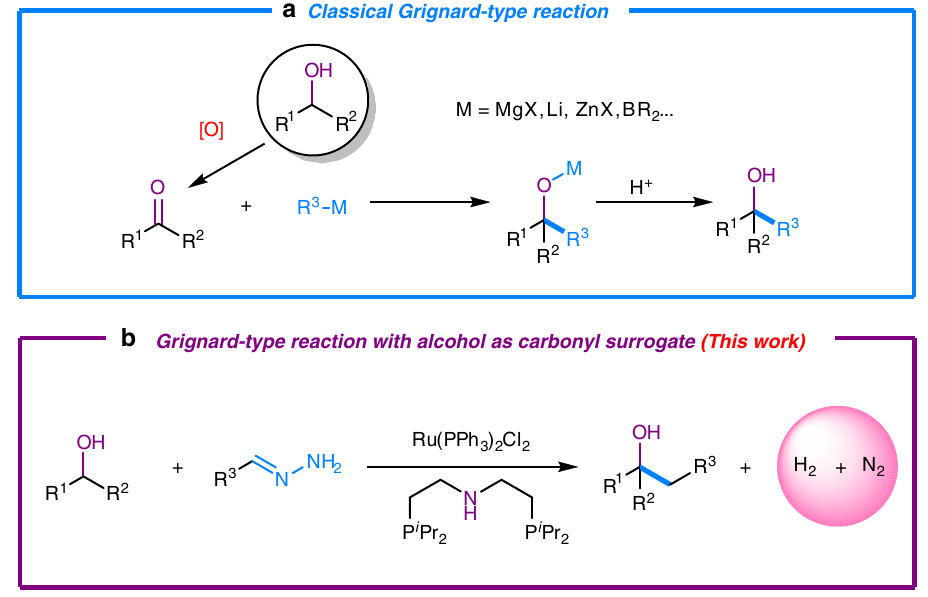
Fig. 2 Grignard-type reaction with alcohol as carbonyl surrogate. a Classical Grignard-type reaction uses carbonyls as starting materials which come from the oxidation of alcohols. Organometallic reagents, in this case, serve as carbanion equivalent. b Alcohol-surrogated Grignard-type reaction, reported in this article, directly uses alcohol as starting material with hydrazones as carbanion equivalent, which skips the process of oxidation and generates hydrogen gas and nitrogen gas as only